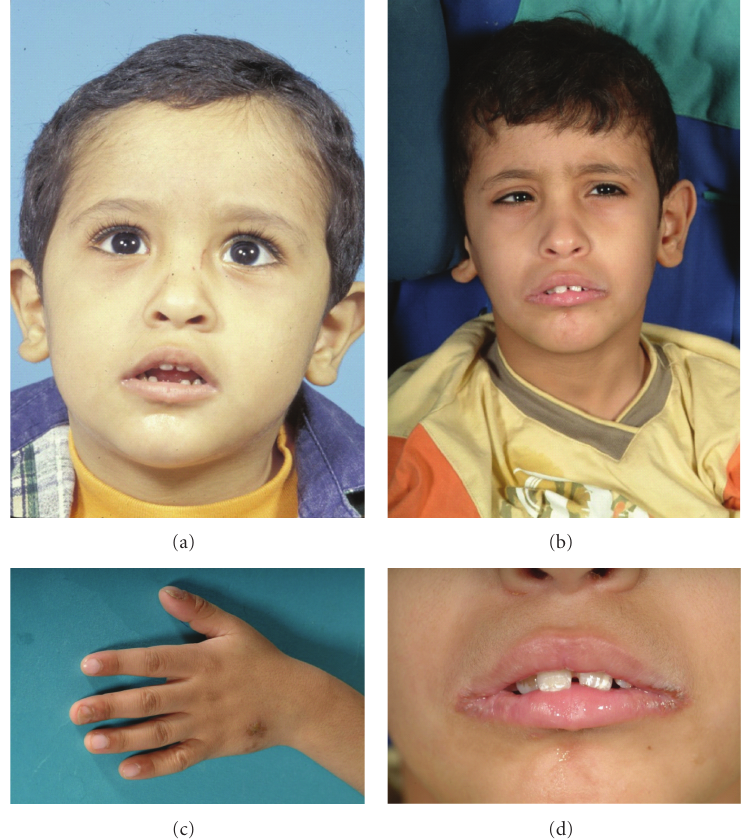
Figure 1: Photograph of the patient showing subtle dysmorphic features with high forehead, flat facies, large protruding ears, and large mouth, at the age of 7 years (a) and at the age of 9 years (b). Fungal infection ( Candida albicans ) of the nails (thumb and middle finger) and dorsum of the hand (c) and around the mouth corners